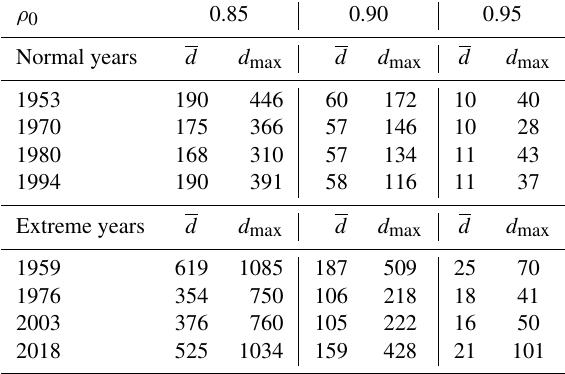
Table 1. Drought in the GE region during the SHY, with average and maximum degrees for ρ 0 = 0 . 85, 0.90 and 0.95 for 4 normal years (1953, 1970, 1980 and 1994) and 4 extreme years (1959, 1976, 2003 and